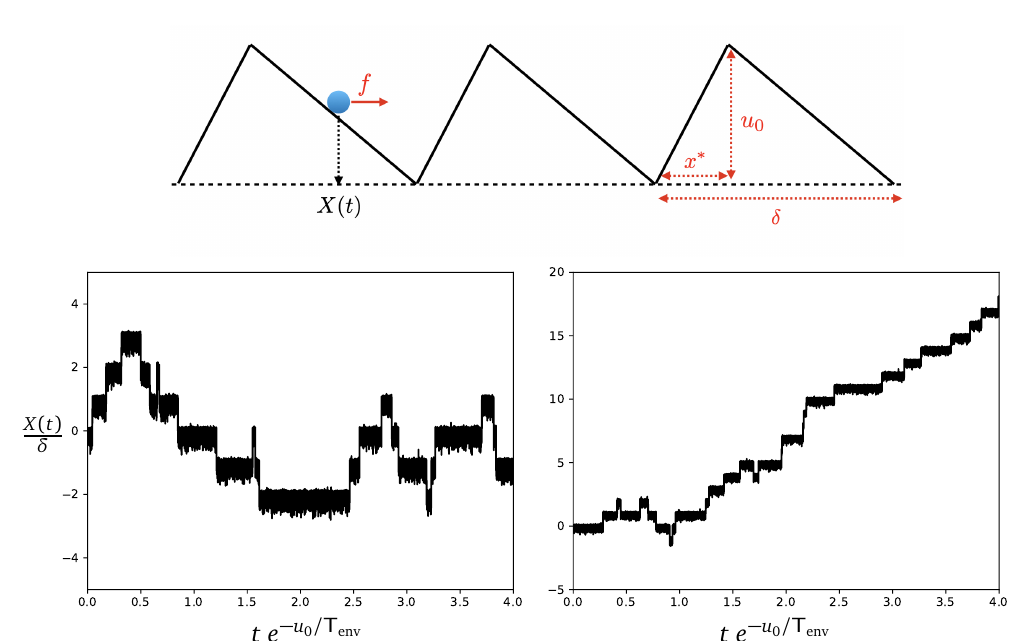
Figure 1: Nonequilibrium version of Kramers’ model exhibiting an increased reaction rate due to nonequilibrium driving . Trajectories shown are for a reaction coordinate (cid:112) /γξ ( t ) , X that solves the Langevin equation ∂ X ( t ) = ( f − ∂ u ( X ( t ))) /γ + 2 T t x env where ξ ( t ) = d W ( t ) / d t is a delta-correlated white Gaussian noise term, and where u ( x ) is a triangular potential with period δ , i.e. u ( x ) = u ( ± δ ) , u ( x ) = u x / x ∗ if 0 ( δ − x ) / ( δ − x ∗ ) if x ∈ [ x ∗ , δ ] . Left: equilibrium trajectory x ∈ [ 0, x ∗ ] , and u ( x ) = u 0 = 1. The remaining with f = 0. Right: nonequilibrium trajectory with f δ/ T env = 10, and T = parameters are set to δ = 5, γ = 1, x ∗ = 1, u 0 env